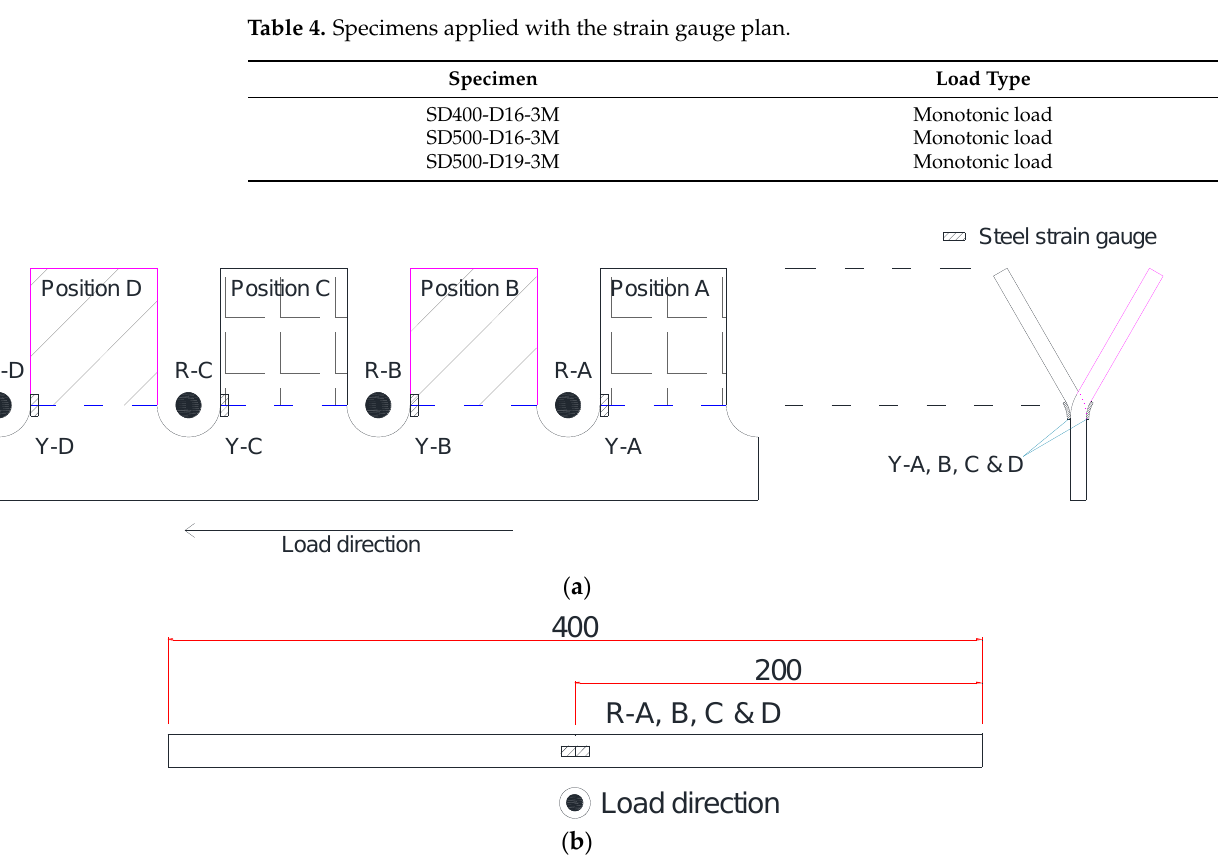
Table 3. Material properties for steel plate and reinforcements (unit: MPa).